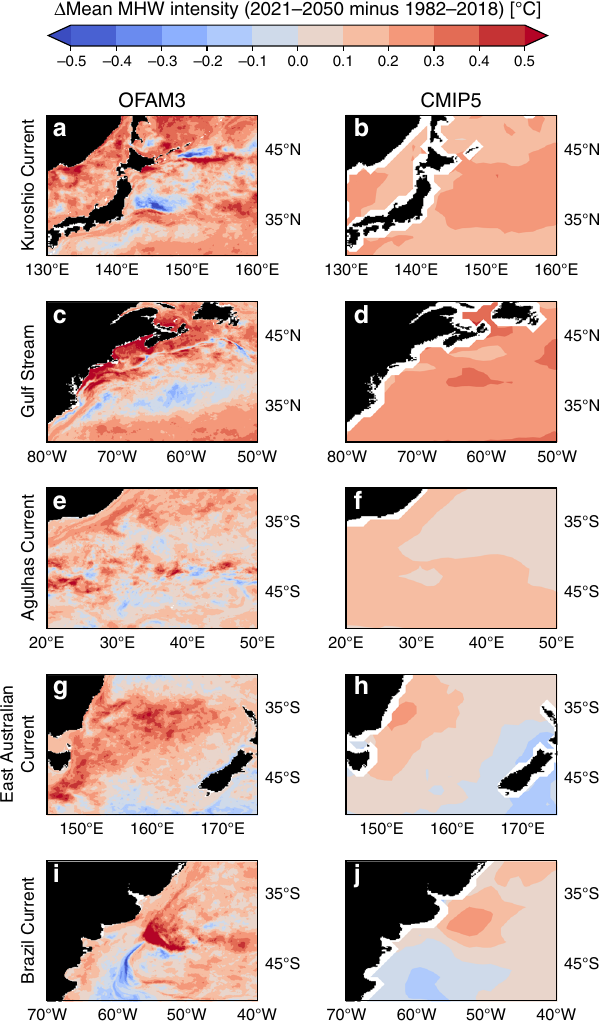
Fig. 6 Projected marine heatwave intensity in western boundary current regions. Spatial comparisons of projected changes (2021 – 2050 minus 1982 – 2018) in mean marine heatwave (MHW) intensity in a , b Kuroshio Current, c , d Gulf Stream, e , f Agulhas Current, g , h East Australian Current, and i , j Brazil Current regions between the high-resolution (0.1°) ocean model output (OFAM3; left column ) and the 1° multi-model mean product of 23 global climate models (CMIP5; right column ) under the Representative Concentration Pathway